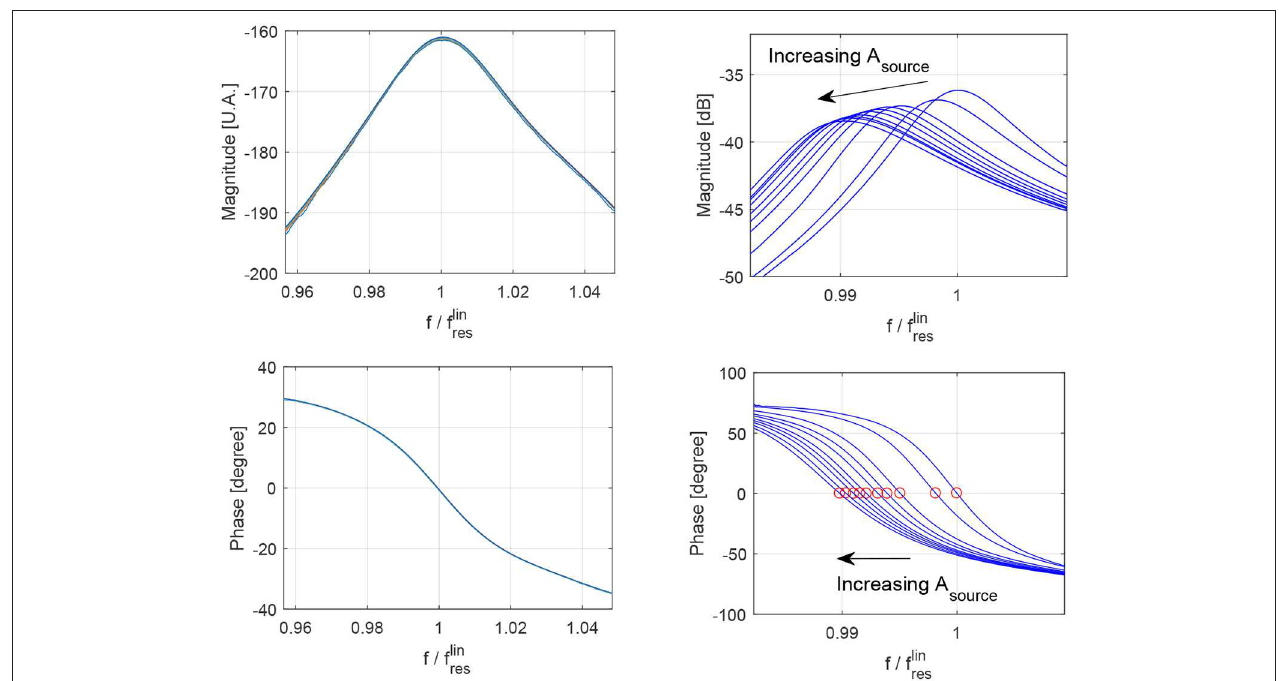
FIGURE 4 | Fast dynamics analysis of polymer concrete samples: phases and amplitudes (normalized to input amplitude) vs. frequency (normalized to linear resonance frequency) of the detected signals at increasing values of A source (input excitation). (Left) Intact sample. (Right) Damaged sample. Red circles in the phase subplot indicates the zero phase crossing, from which the resonance frequency could be derived at each amplitude of excitation. Note that the experiment is performed in order to minimize effects due to slow dynamics. Here, at each amplitude the sample is excited for a very short time. Thus, conditioning effects, which are time cumulative, could be considered as negligible.